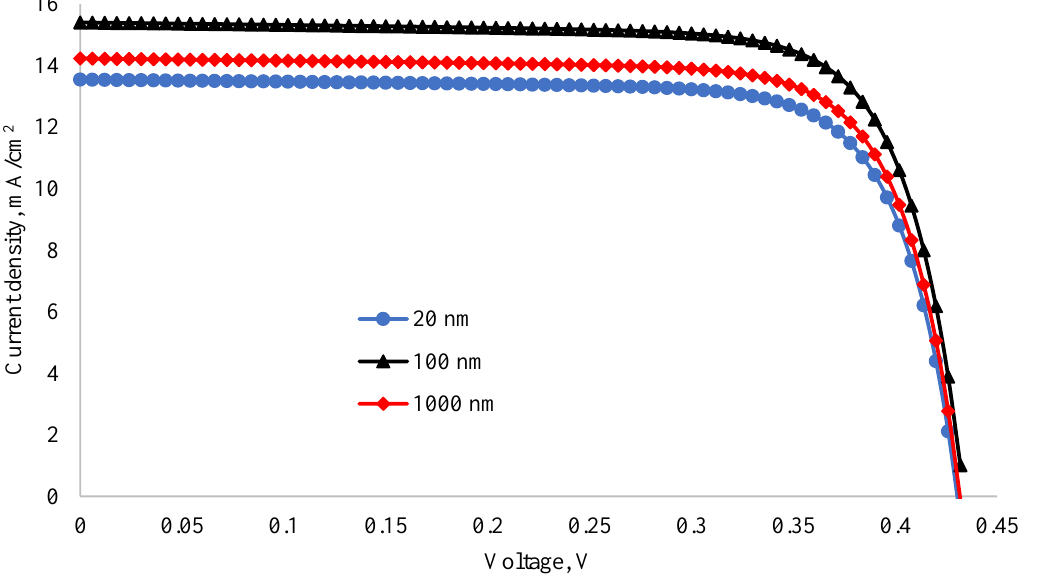
Figure 8. I-V characteristic of the MoO 3 /Si solar cell with different thicknesses of MoO 3. According to the I-V characteristics given in Figure 8, since the photoelectric param- eters change nonlinearly depending on the thickness, the dependence of the short-circuit current on the thickness of the MoO 3 layer was studied and shown in Figure 9. The MoO 3 layer thickness was changed from 20 nm to 1200 nm. A sharp change in short-circuit cur- rent was observed in the thin layers. When the thickness was 20 nm, the minimum short- circuit current was 15.54 mA/cm 2 ; when the thickness was 60 nm, the maximum short- circuit current was 18.15 mA/cm 2 .